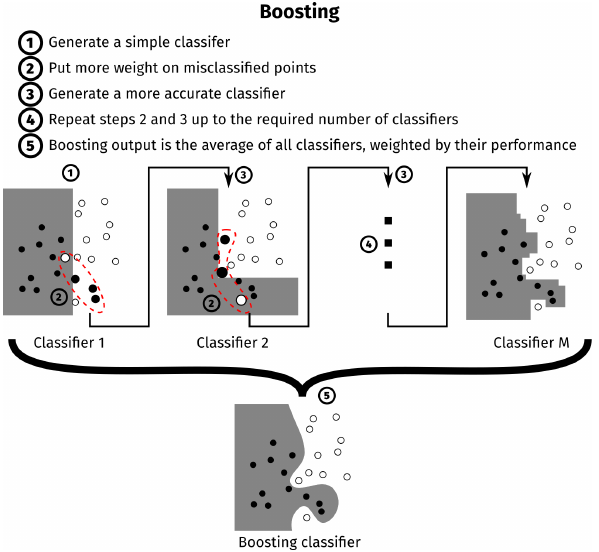
Figure 3. Illustration of boosting on two-dimensional artificial data with two